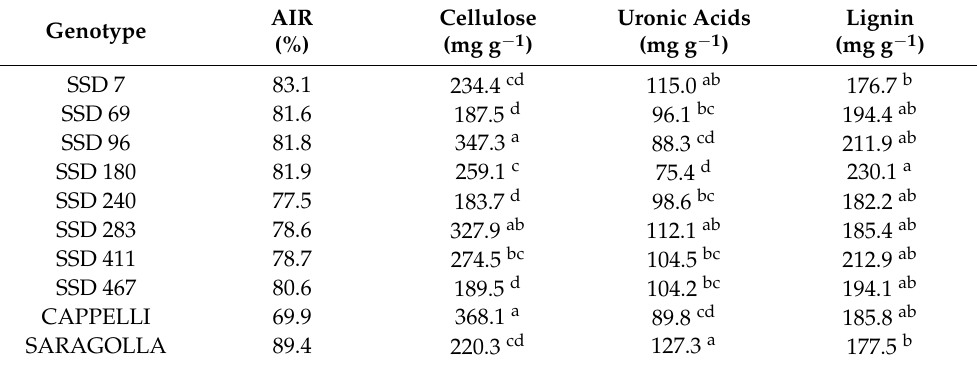
Table 3. Polysaccharide content of cell wall. Cellulose and uronic acids content were expressed as mg of cellulose or galacturonic acid (GalA) g − 1 of biomass. Klason lignin content was expressed as mg of lignin g − 1 of biomass. The AIR (alcohol insoluble residue) was expressed as percentage of AIR respect to the